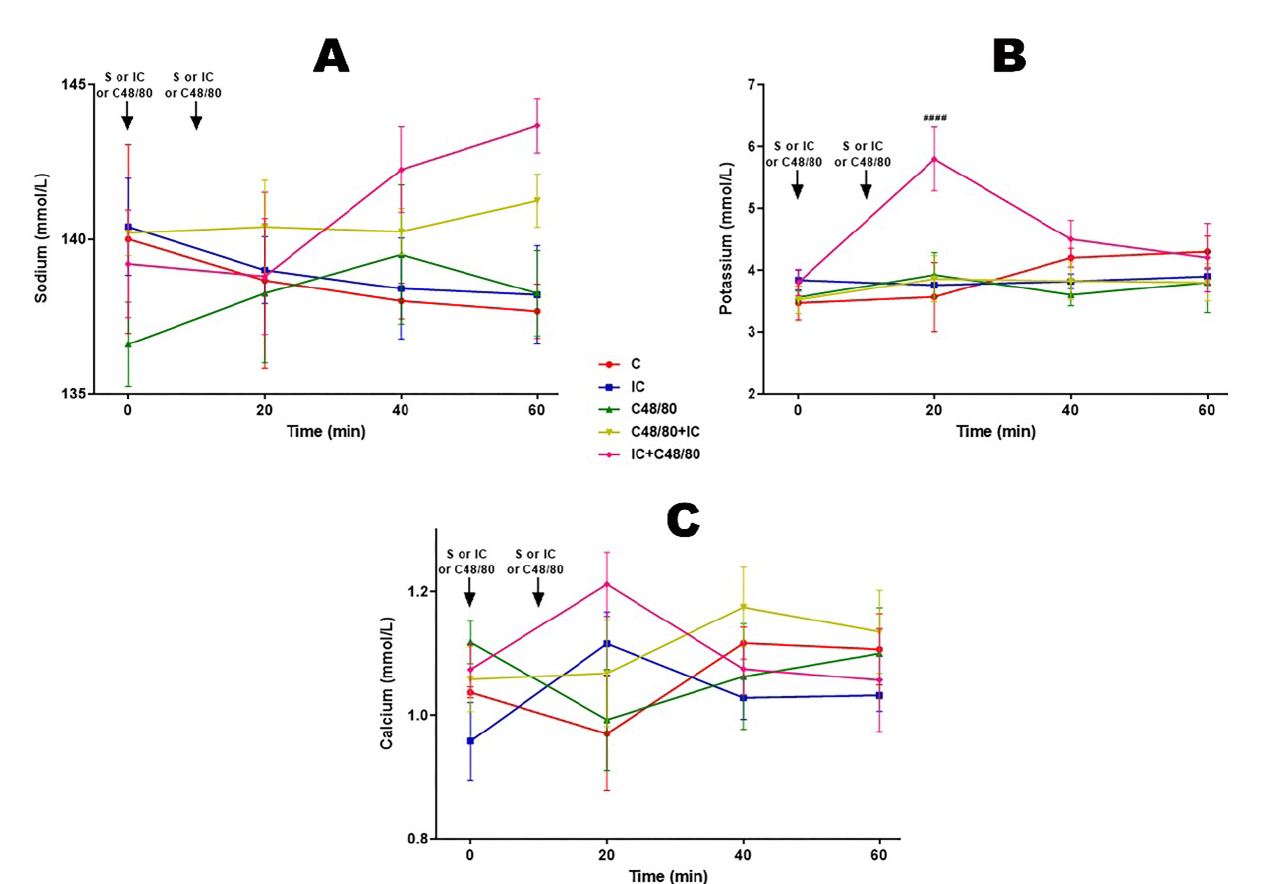
Fig. 7 - Electrolytes. Effect of anaphylactic shock caused by compound 48/80 (C48/80) and treated with indigo carmine (IC) in pigs. A) Sodium; B) potassium; C) calcium. At minute 0, the control (C) group received saline (S), the C48/80 and C48/80 + IC groups received C48/80, the IC and IC + C48/80 groups received IC. At minute 10, the C, IC, and C48/80 groups received S, the C48/80 + IC group received IC, and the IC + C48/80 group received C48/80. Data represent means ± standard error of mean and analyzed by two-way analysis of variance (ANOVA), Dunnett post- test (n=5). #### P<0,0001. ( # C vs. IC +